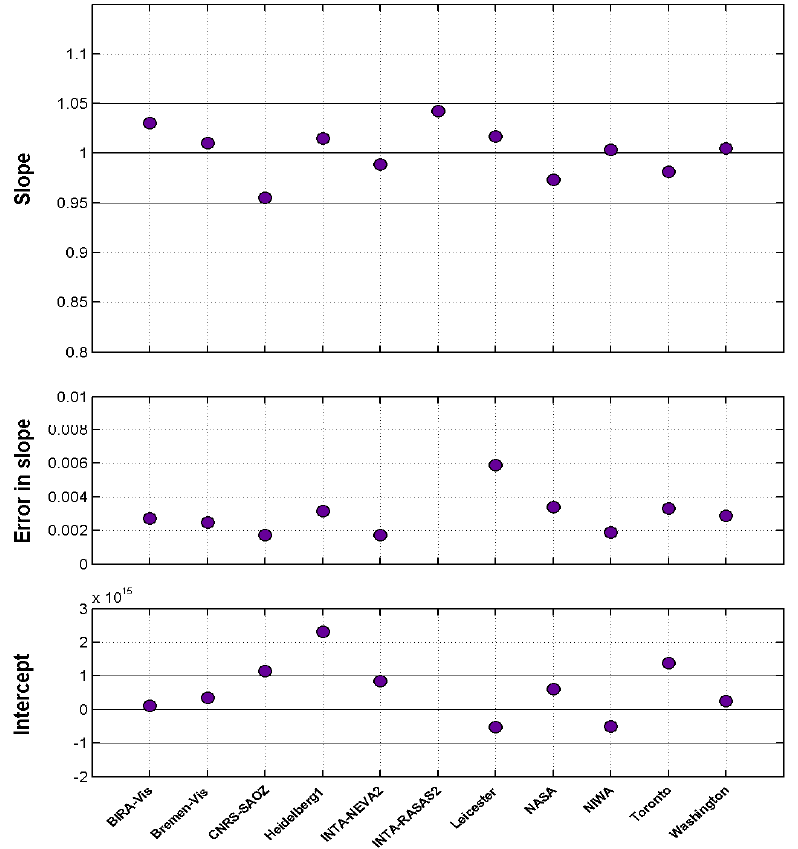
Fig. 16. Slopes, errors in slope, and intercepts, of straight line fits of each instrument’s data to that of INTA, for the whole campaign, after the slopes from fits such as those of Figure 15 were normalised by dividing by the mean of the slopes of all instruments.